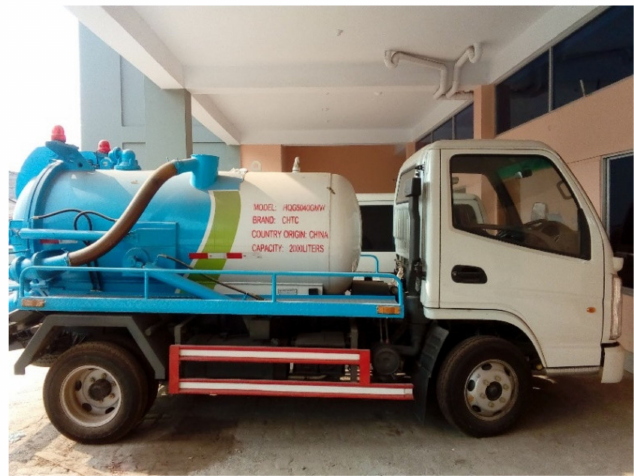
Figure 1. Khulna City Corporation (KCC)